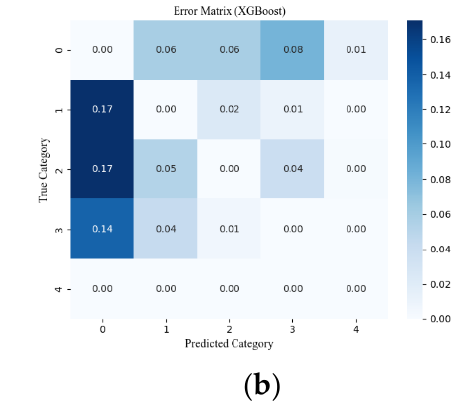
Figure 3. Error matrix ( a ) of textCNN; ( b ) of XGBoost. After merging with the annotated text, we obtained a total of 1479 (32.8%) sentences with unmet autonomy, competence or relatedness needs. The distribution of different categories in the annotation set and the overall dataset is shown in Figure 4. The proportion of Class 2 in the whole data set is greater than that in the annotation set because textCNN could predict sentences of Class 0 as Class 2. The annotation and prediction results of all the 4507 sentences can be accessed via uploaded Supplementary